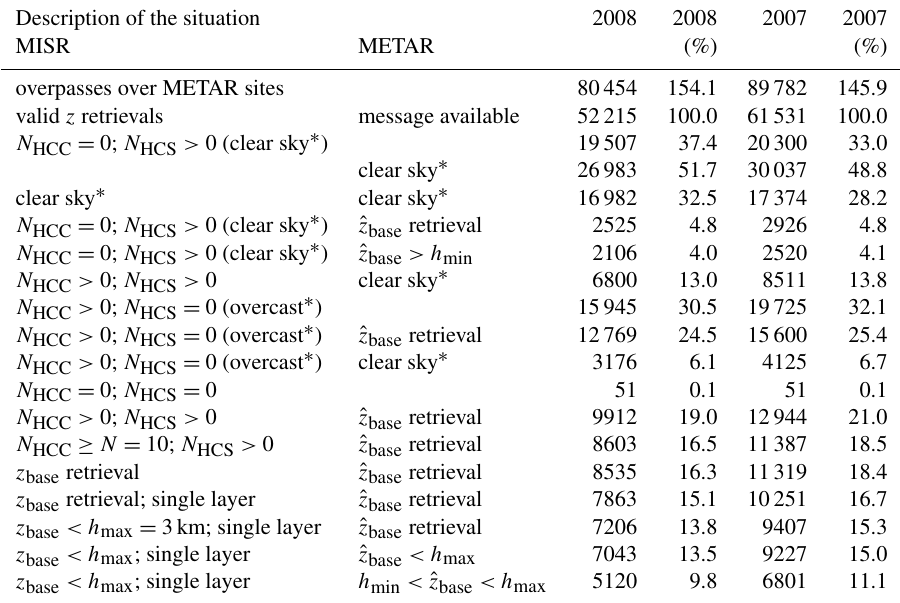
Table 5. Number of cases for different conditions of the cloud field observed by MISR and reported in METAR messages for the considered METAR sites. The number of z retrievals labeled “high confidence cloud” ( N HCC ) or “high confidence surface” ( N HCS ) according to MISR’s stereo-derived cloud mask is used to characterize the cloud field. The size of the scene is defined by R c =